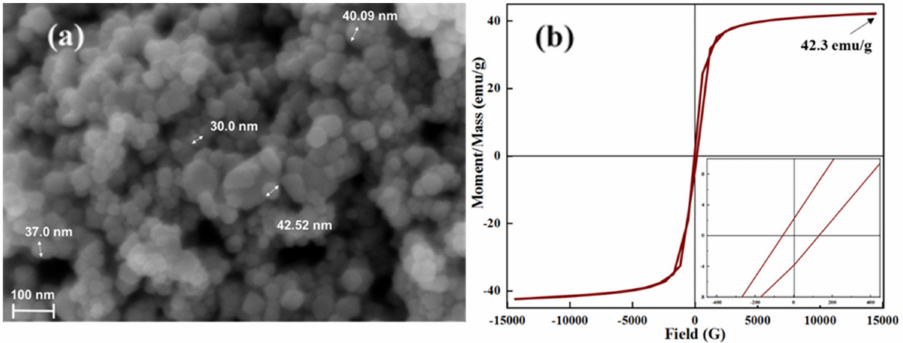
Figure 4. ( a ) Field emission scanning electron microscope (FESEM) image showing particle size and the shape of a magnetite nanoparticle and ( b ) hysteresis loop, the inset shows a magnified image of the initial